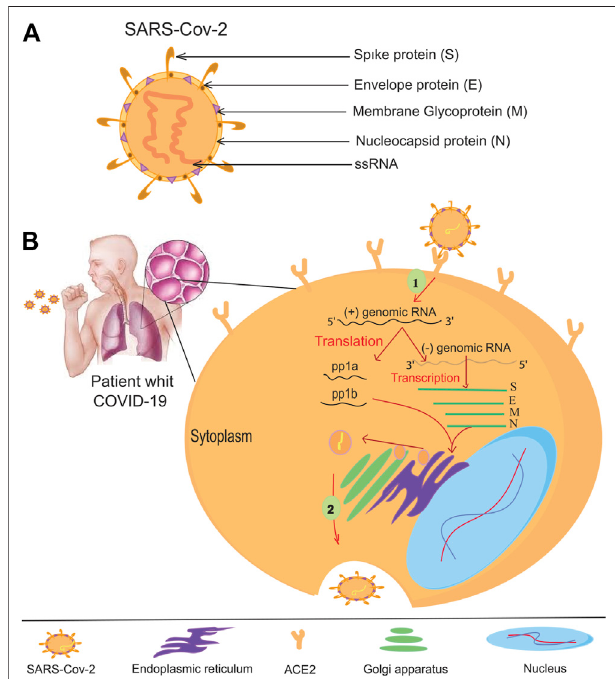
FIGURE 1 | The coronavirus virion and its life cycle. (A) Typical structure and proteins of the coronavirus virion. The coronavirus genome encodes an (S) spike glycoprotein, an (E) envelope glycoprotein, an (M) membrane glycoprotein,andan(N)nucleocapsidprotein. (B) Toenterthehostcells, theSARS-CoV-2virusbindstotheACE-2receptorsofthehostcellhelpedby protein (S), then the RNA of the virus enters the host cell. All viral products are provided at the expense of the host cell, so many viruses are produced by virus-infected